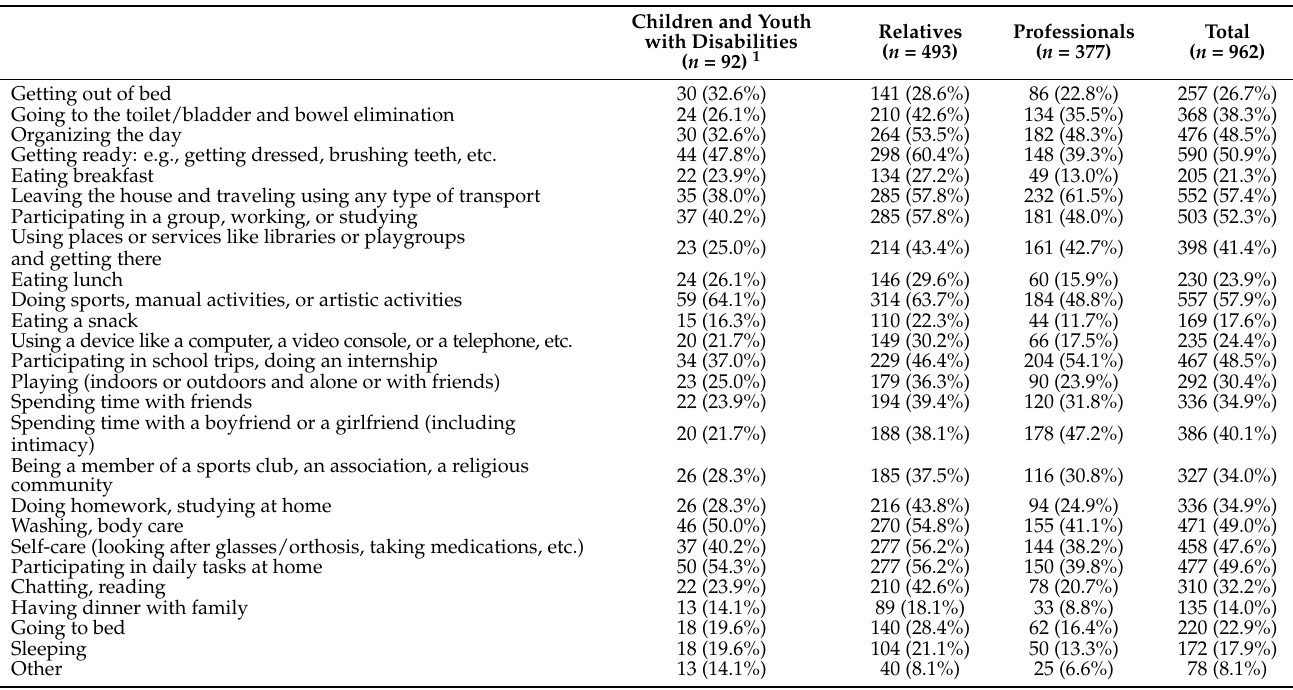
Table 2. Study results for difficulties during a typical day.